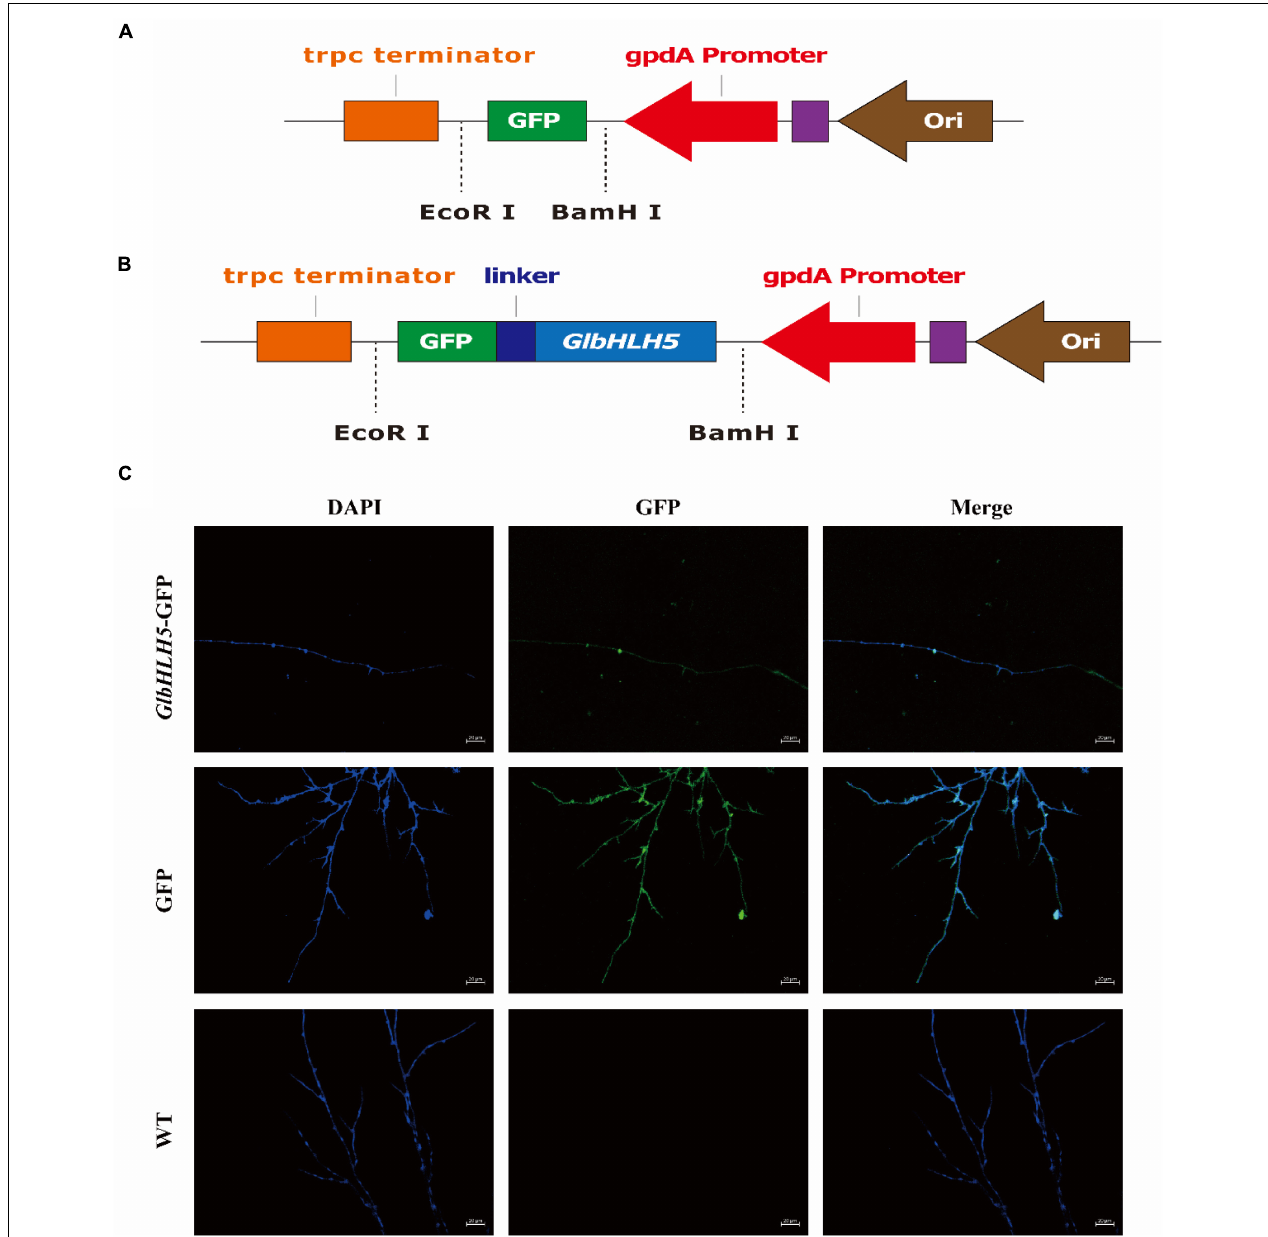
FIGURE 5 | Subcellular localization analysis of GlbHLH5. (A) Construction of the vector pBARGPEI-GPF. (B) Construction of the vector pBARGPEI- GlbHLH5 -GPF. (C) Subcellular localization of GlbHLH5 protein in Ganoderma lucidum . DAPI, DAPI nuclear staining; GFP, the field of view under green excitation fluorescence; Merge: the overlapping field of view of DAPI and